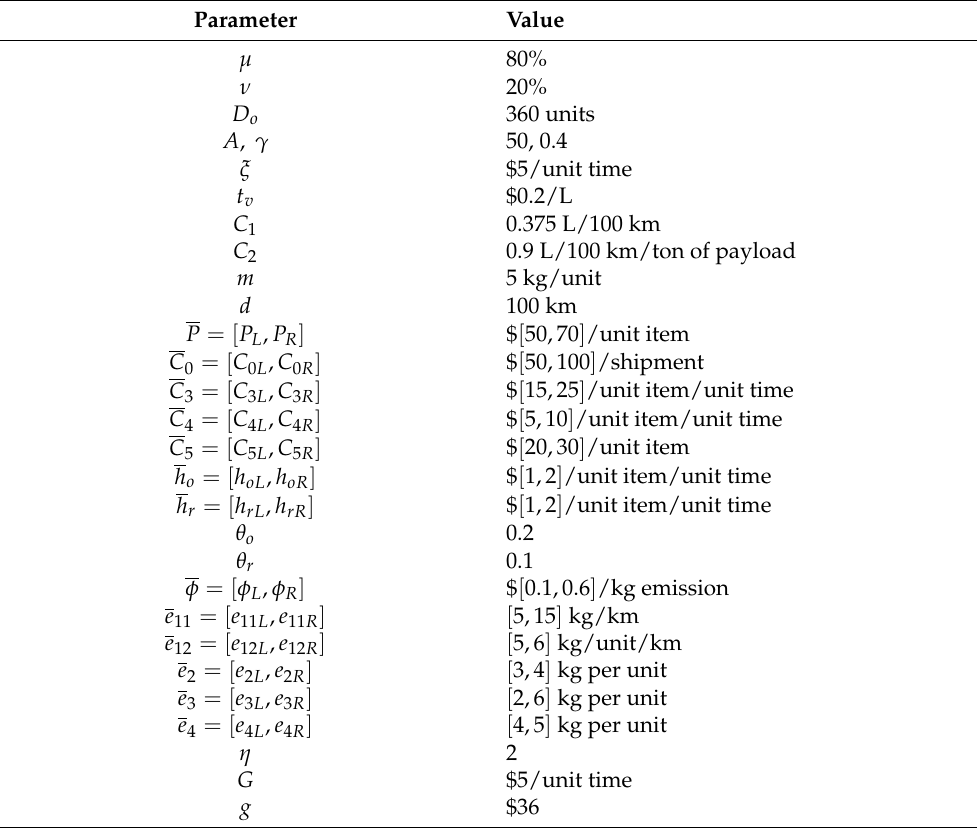
Table 2. Numerical data for the given case